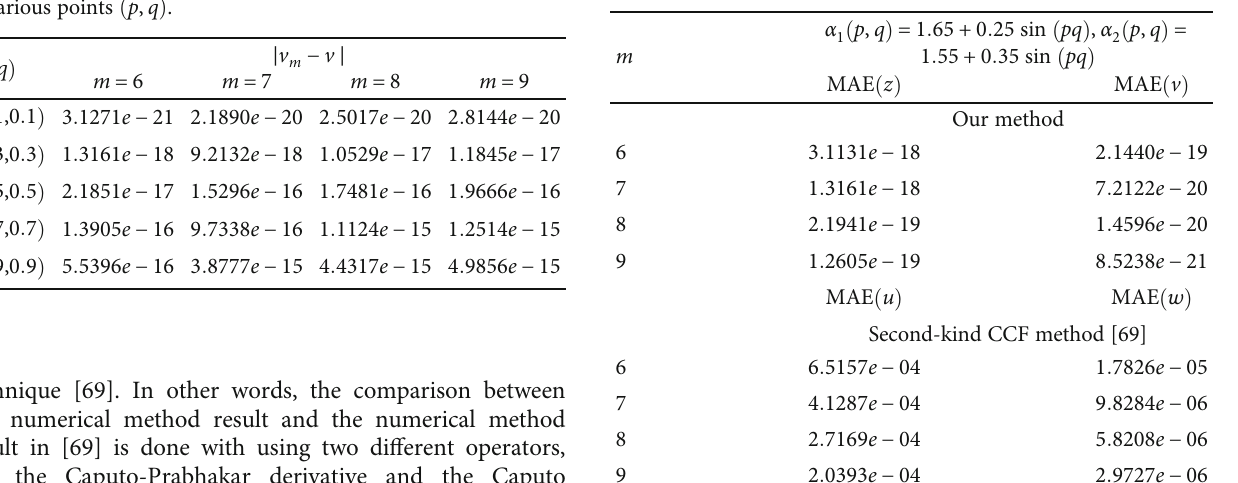
Table 12: Comparison of the numerical results for Example